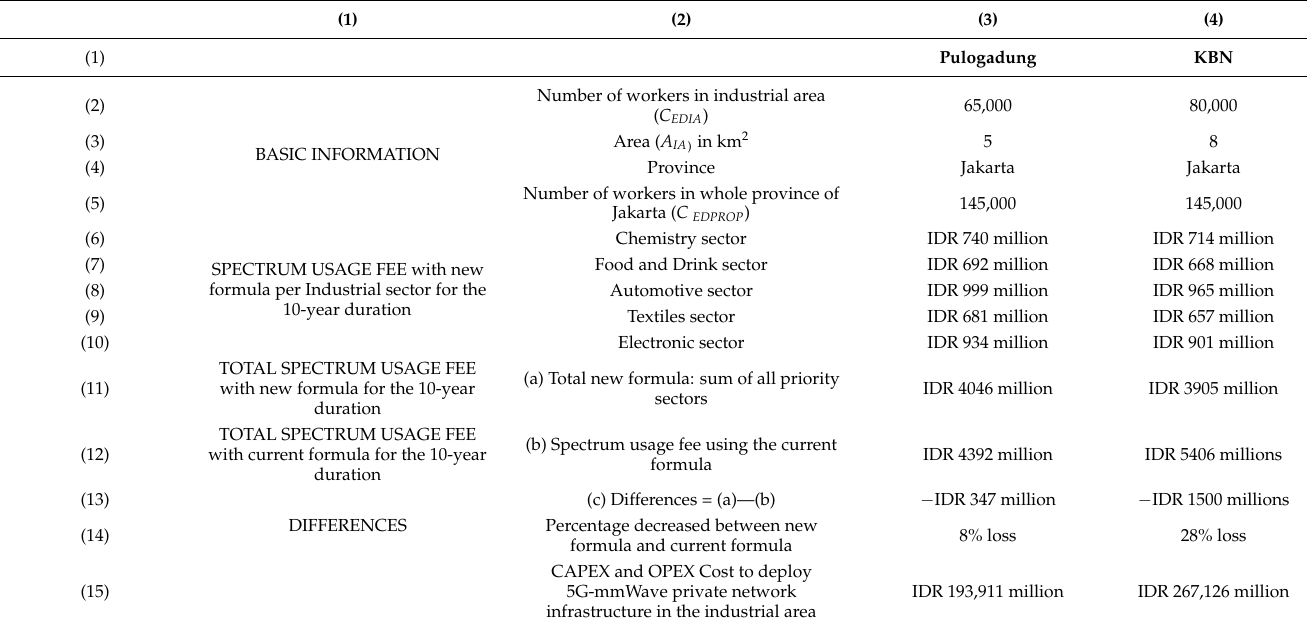
Table 6. Spectrum usage fee comparison between the current and proposed new formula in five priority industries (IDR) and 5G-mmWave private network deployment costs for the 10-year duration of the spectrum usage